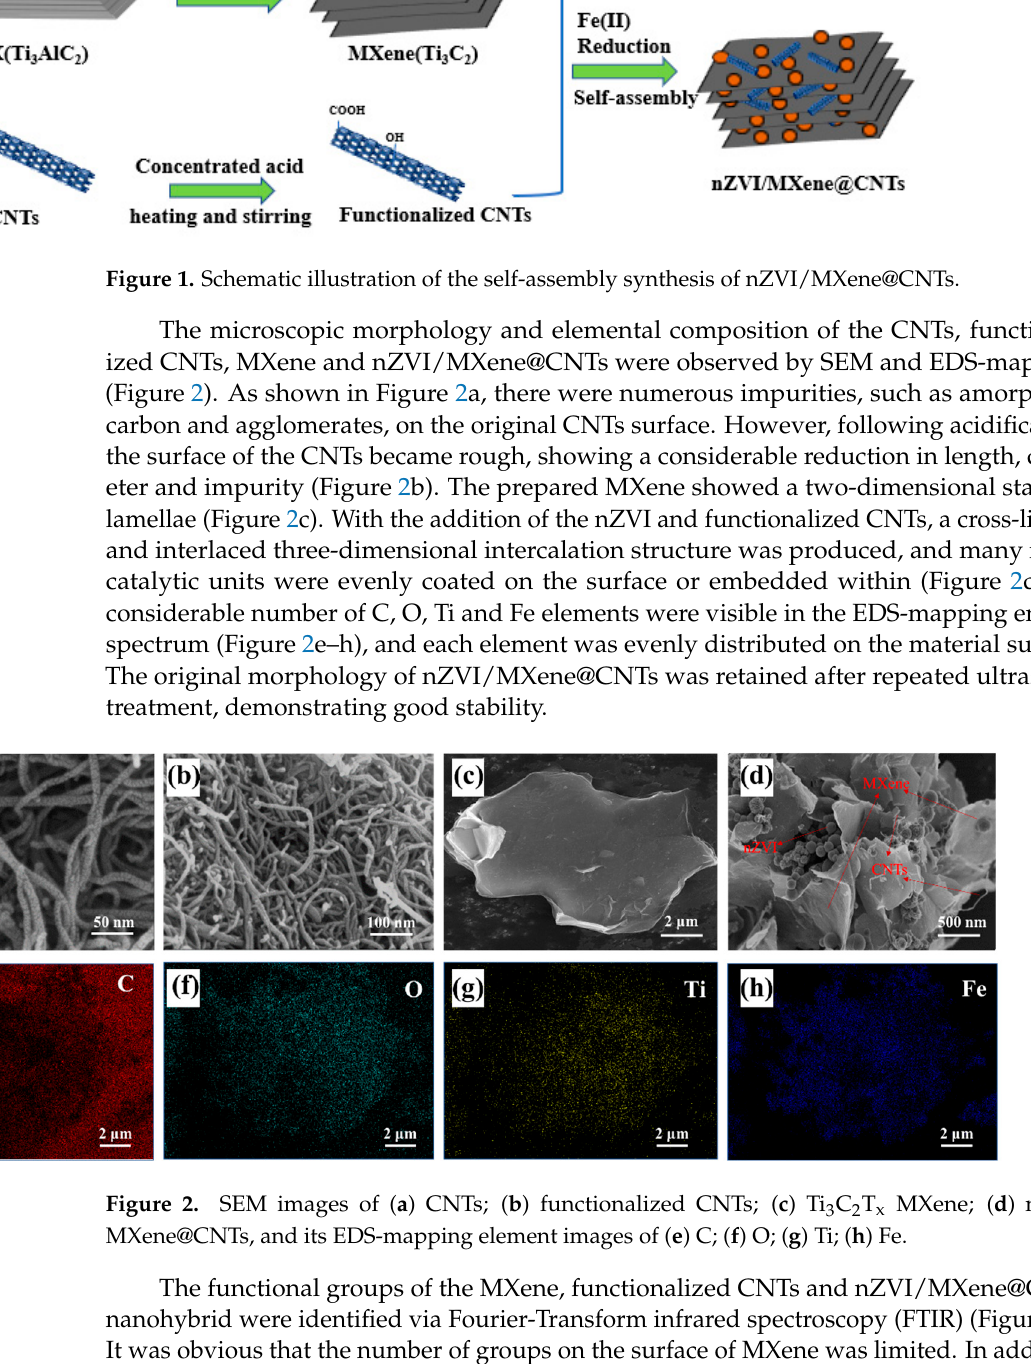
Figure 2. SEM images of ( a ) CNTs; ( b ) functionalized CNTs; ( c ) Ti 3 C 2 T x MXene; ( d ) nZVI/MXene@CNTs, and its EDS-mapping element images of ( e ) C; ( f ) O; ( g ) Ti; ( h ) Fe.